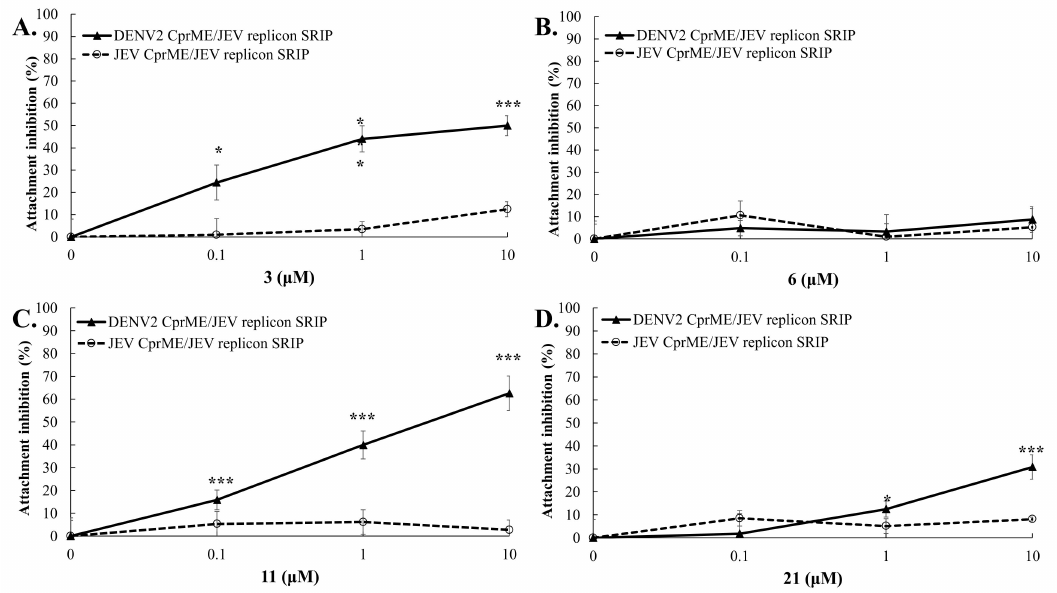
Figure 6. Attachment inhibition of chimeric DENV2 CprM-E/JEV and wild-type JEV SRIPs by active GL conjugates. Vero E6 cells were pre-cooled and incubated with freshly prepared mixtures of DENV2 CprM-E/JEV or wild-type JEV SRIPs, with active GL derivatives 3 ( A ), 6 ( B ), 11 ( C ), and 21 ( D ) at 4 ◦ C for 1 h, respectively. After the removal of the mixtures, the cells were kept at 37 ◦ C for 18 h and then an immunofluorescent assay with anti-JEV NS5 antibodies plus DAPI staining was performed. Finally, the inhibition percentage of SRIP attachment infectivity was measured as follows: 1-(percentage of JEV NS5 positivity in treated cells/percentage of JEV NS5 positivity in mock-treated cells). * p < 0.05; *** p < 0.001 compared with untreated, infected cells.